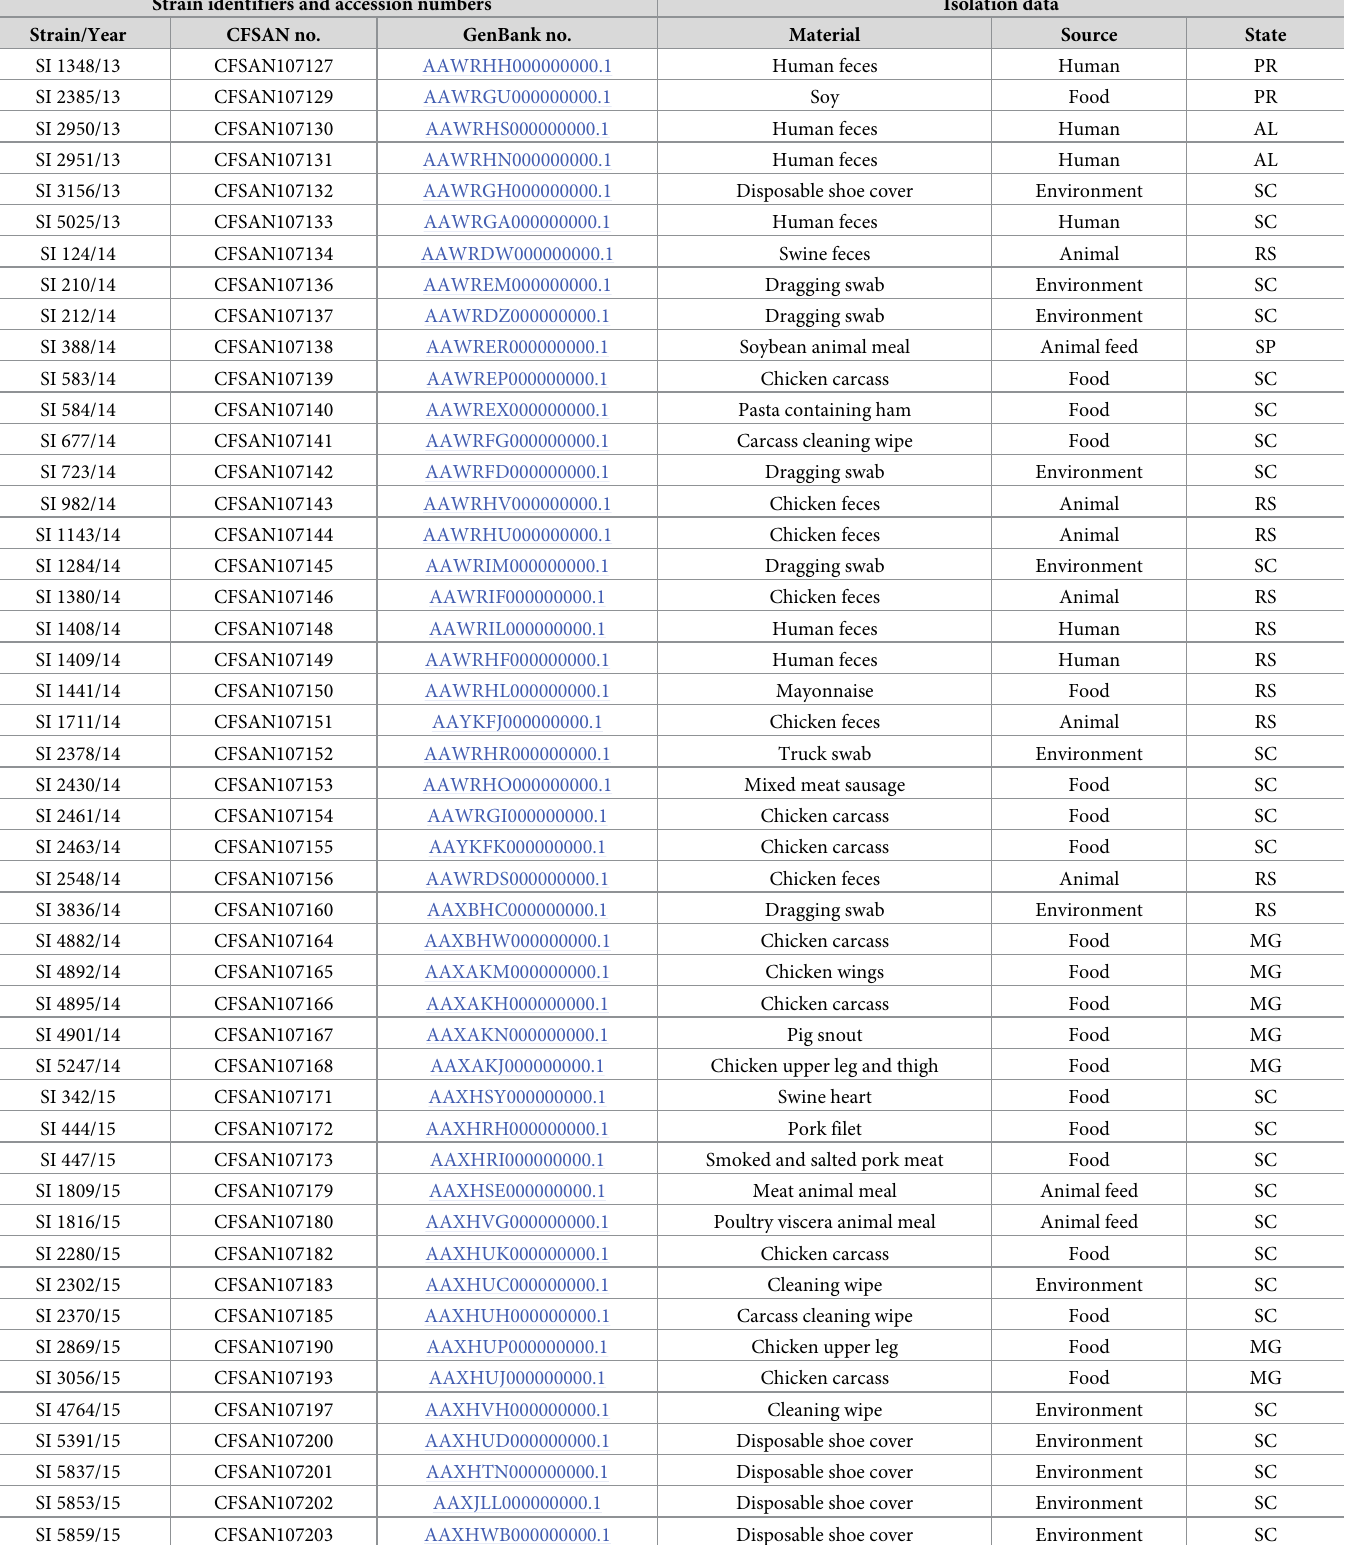
Table 1. Strain identifiers and isolation data of the 80 Salmonella Infantis strains studied isolated from food (n = 27), farm and industry environments (n = 24), humans (n = 19), animals (n = 7) and animal feed (n = 3) between 2013 and 2018 in